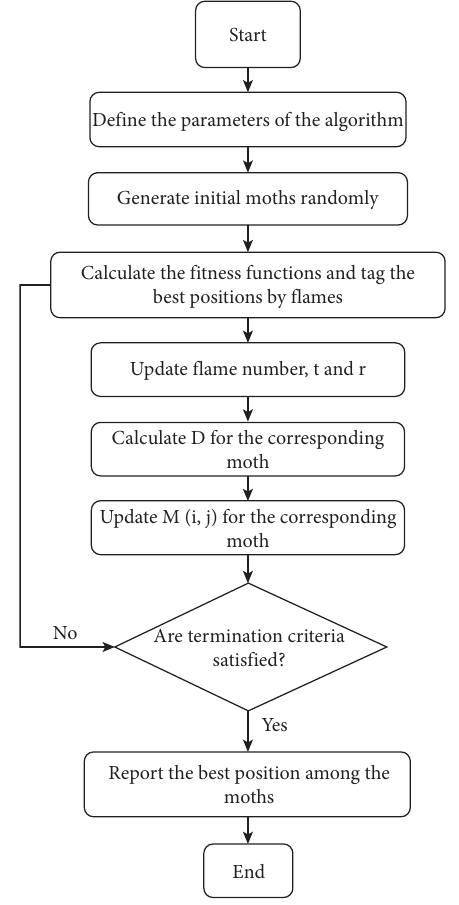
Figure 5: Flowchart of the MFO algorithm (Shehab et al.,